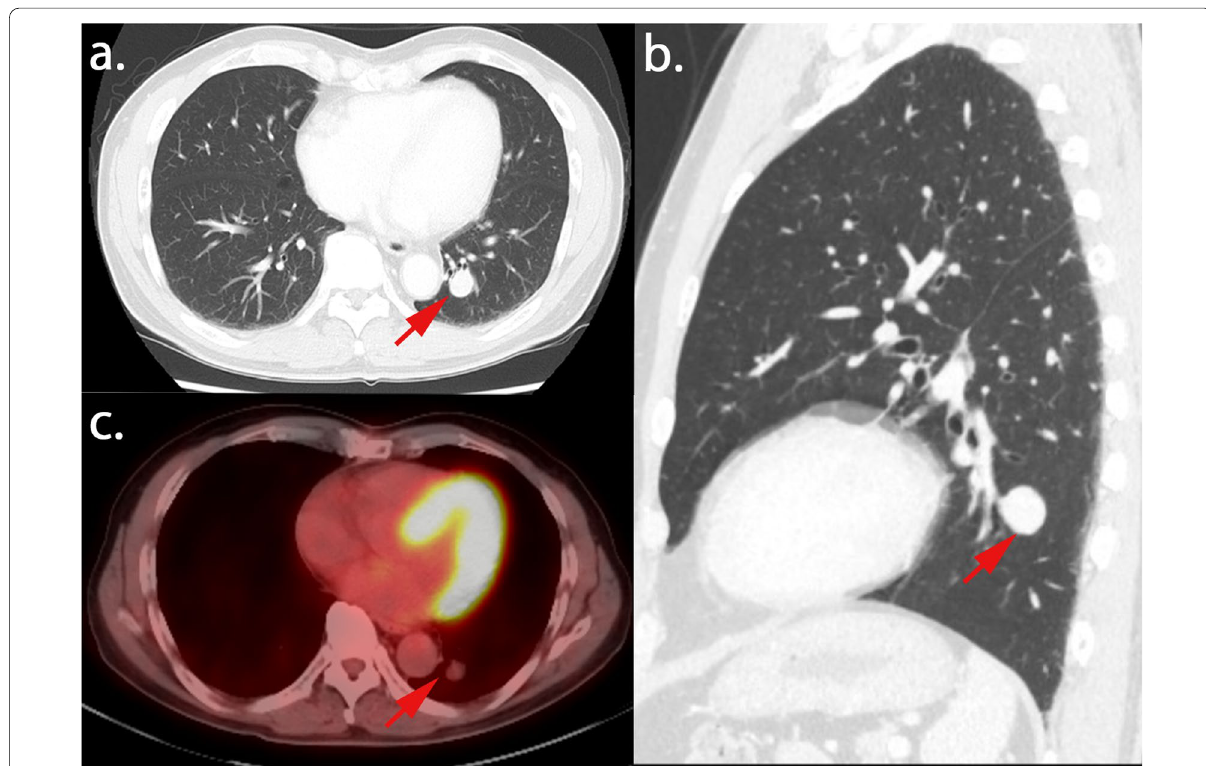
Fig. 3 a , b Chest computed tomography findings. The nodule of the left lower lobe increased in size, and it was near the segmental bronchus. c 18 F-fluorodexyglycose positron emission tomography/computed tomography reveal a little uptake (SUV